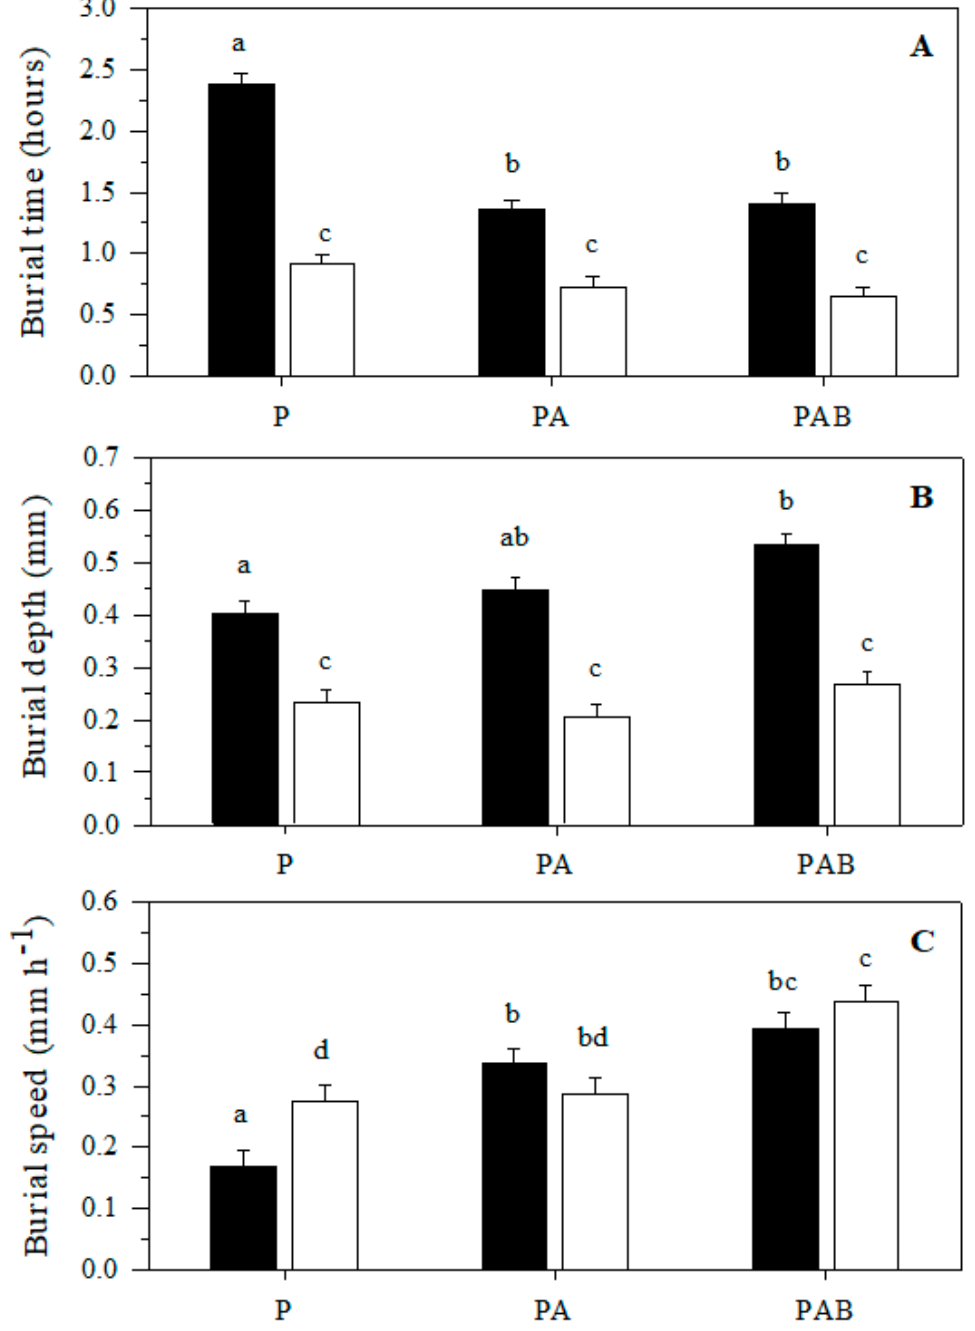
Figure 3. Burial time ( A ), burial depth ( B ) and burial speed ( C ) of adults (black bars) and juveniles (white bars) of the sea anemone A. hermaphroditica in the sediment during exposition to P (PAR), PA (PAR + UVA) and PAB (PAR + UVA + UVB) radiation treatment. Bars show mean ± SE. Different letters over bars indicate significant differences ( p <